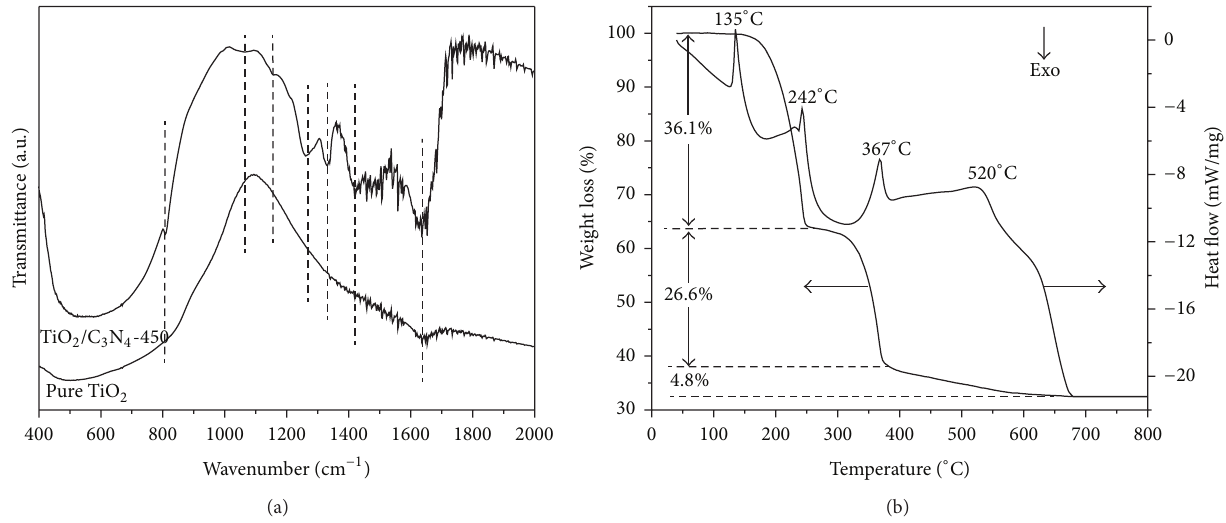
Figure 3: FTIR spectra of pure TiO 2 and g-C 3 N 4 /TiO 2 nanocomposites (a) and TG-DSC for heating the mixture of TiO 2 and urea